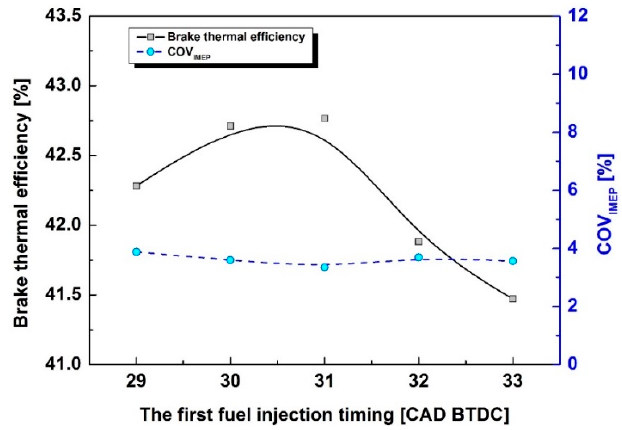
Figure 5. Variations in brake thermal efficiency and combustion stability according to the change in the first fuel injection timing with a fuel injection ratio of 60%/40% and fixed second fuel injection and SA timing at 1600 rpm and BMEP of 0.24 MPa.